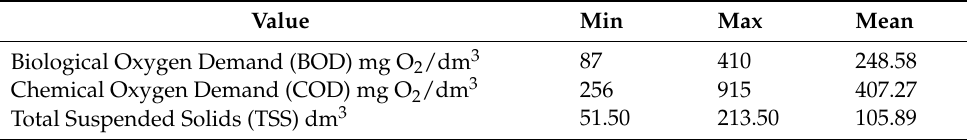
Table 1. Concentration of organic matter and suspended solids in the outflow of the septic tank. Value Min